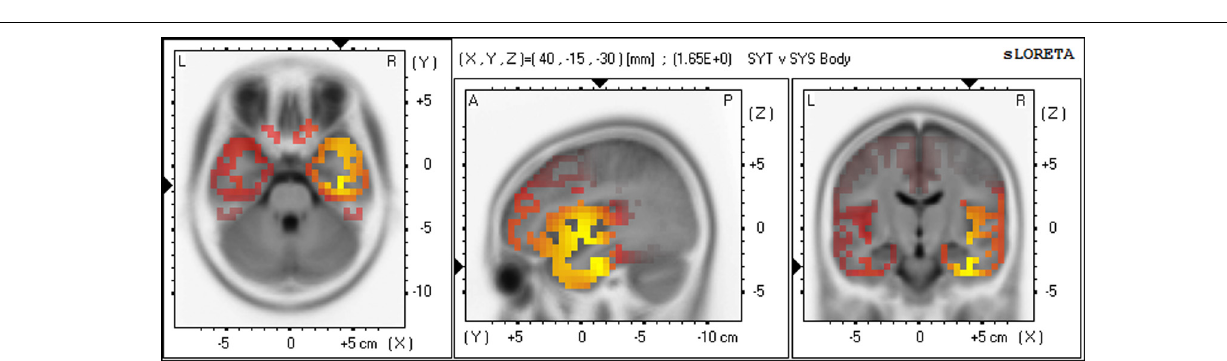
FIGURE 5 | Differences in CSD between groups in gamma band in Meditation 1 (Body-steadiness) Increased gamma activity (yellow) in SYT compared to SYS in right BA20 (fusiform gyrus).